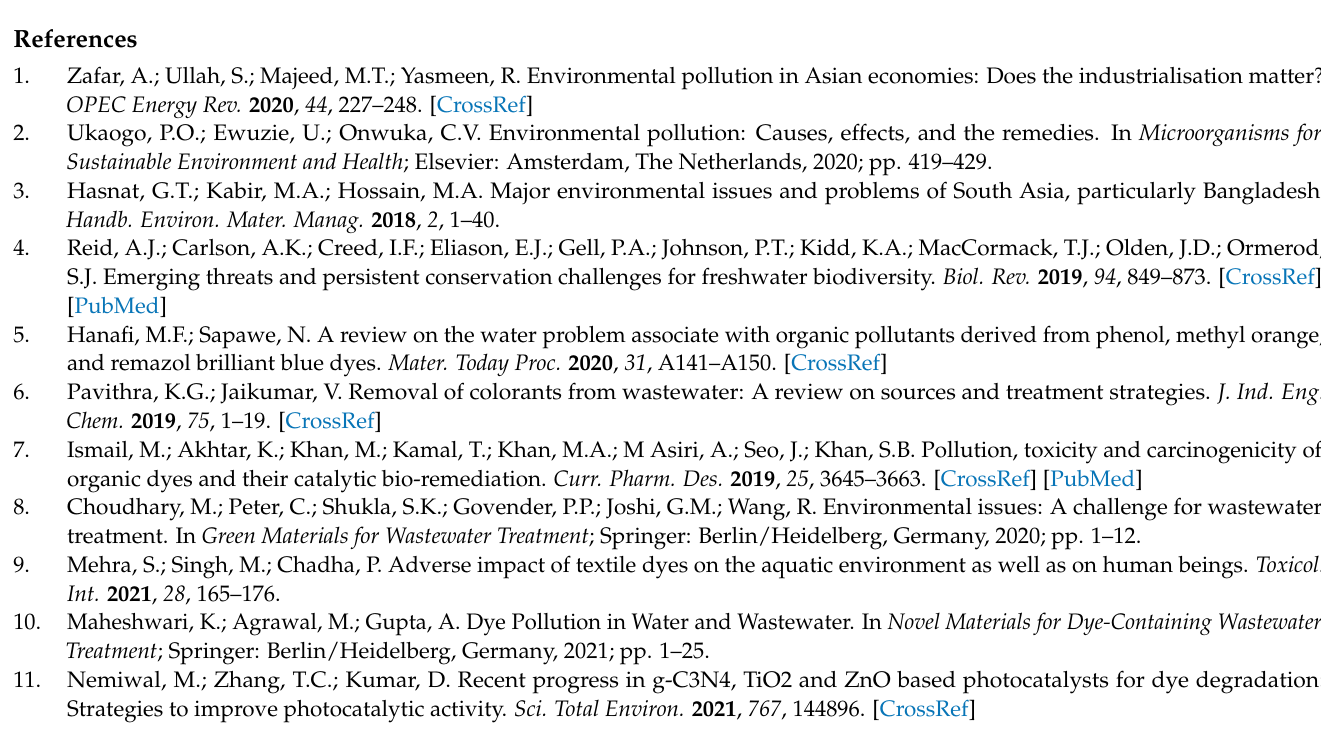
rianum ; Figure S2: Effect of different concentrations of dyes on the degradation process; Figure S3. Effect of different concentrations of photocatalyst on the degradation process; Figure S4. Thermody- namic study of dyes degradation; Figure S5. Dyes degradation upon recycling of the photocatalyst; Table S1. Thermodynamic parameters for MG degradation on CuO NPs; Table S2. Thermodynamic parameters for MO degradation on CuO NPs; Table S3. RMSE calculations for degradation of MG; Table S4. RMSE calculations for degradation of MO. Table S5. Dyes used in this work. Refs. [102–105] are cited in supplementary